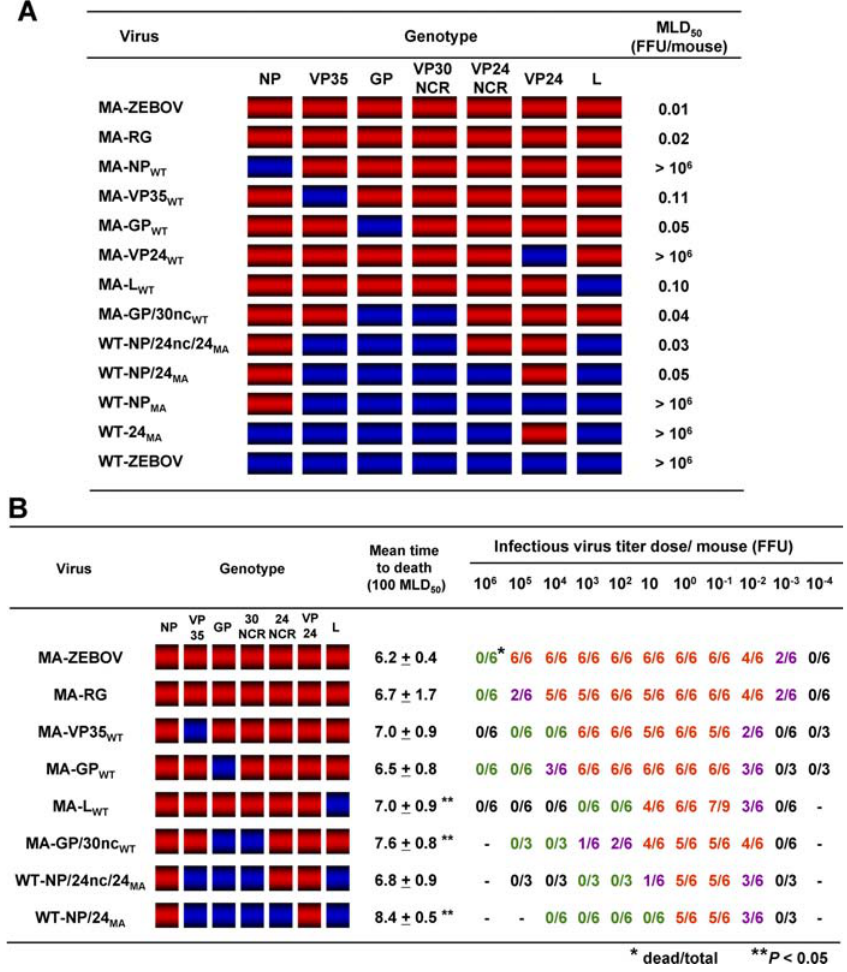
Figure 2. Genetic Determinants of Virulence in Adult Mice (A) Determination of MLD 50 values. Bars indicate the genotype of the viral gene: MA-ZEBOV (red), WT-ZEBOV (blue). The MLD 50 values of recombinant viruses were determined by i.p. inoculation of mice (three to six per group) with serial 10-fold dilutions of virus stock and then monitoring of survival rates. Experiments were carried out in duplicate. (B) Determination of the mean time to death and dose ranges causing morbidity/mortality. The mean time to death of mice inoculated with 10 FFU (approximately 1,000 MLD 50 for MA-ZEBOV) are indicated. Differences in the mean time to death for mice infected with various mutants, compared to that of mice infected with MA-ZEBOV, were considered significant when the p- value was , 0.05. The dose range for morbidity/mortality was determined by inoculating groups of six to nine mice with the indicated amounts of viruses and monitoring the mice for weight loss and time to death. Survival numbers (dead/total) are color-coded to indicate the severity of infection in infected mice: no disease (black), illness without mortality (green), less than or equal to 50% mortality (purple), greater than 50% mortality (red). *Dead/total. ** p , 0.05. DOI: 10.1371/journal.ppat.0020073.g002